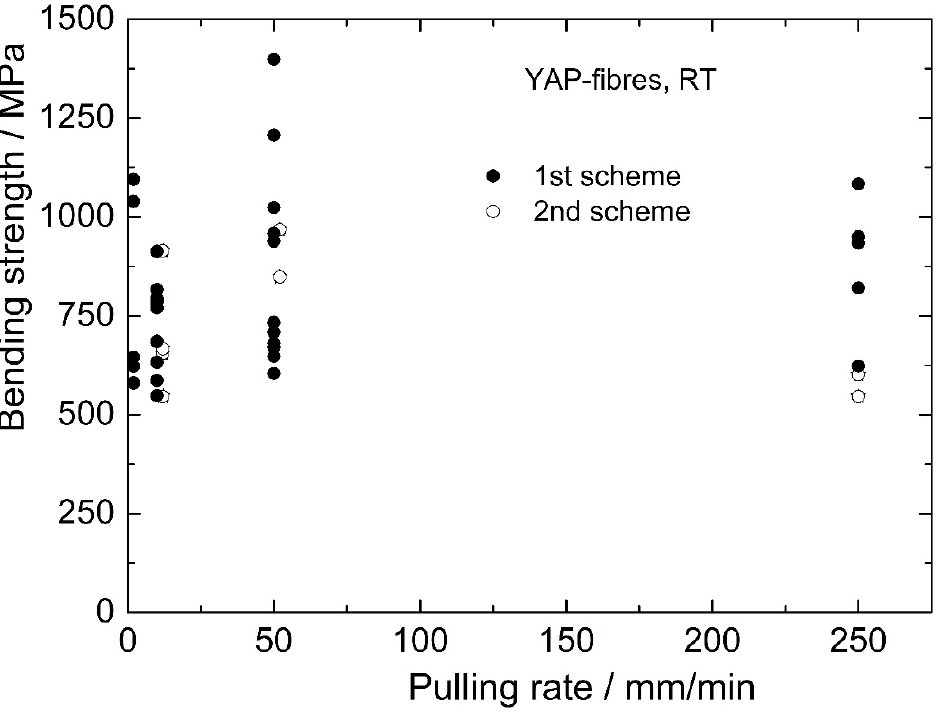
Figure 11. Dependence of the effective strength of the fibers on the crystallization rate.